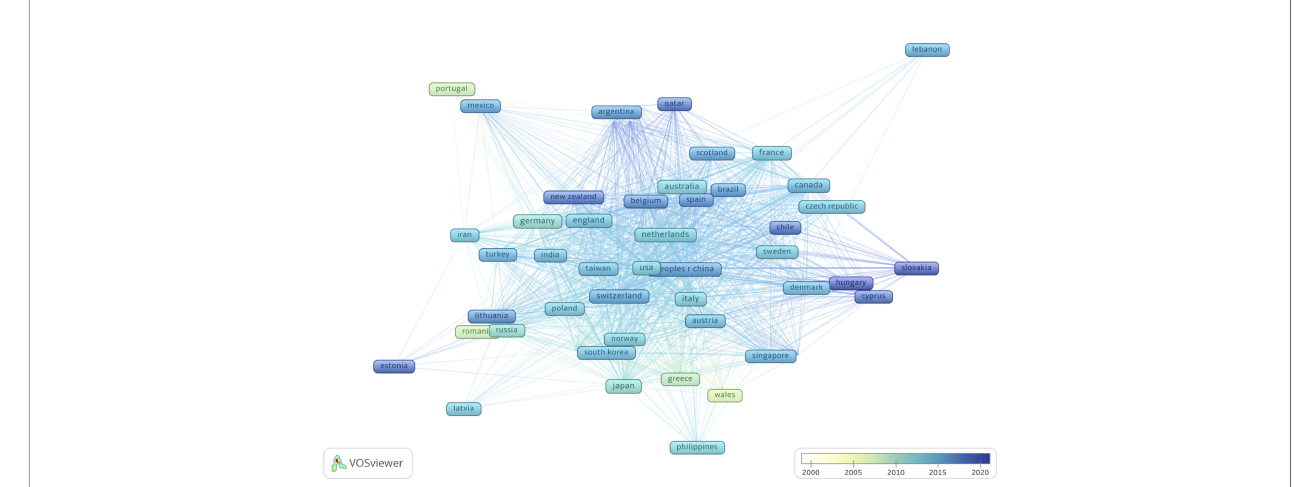
FIGURE 3 | Co-citation network of countries based on VOSviewer. The color of node and line represents different years, colors vary from white to deep blue as time goes from 2000 to 2020 and the links indicate the co-occurrence